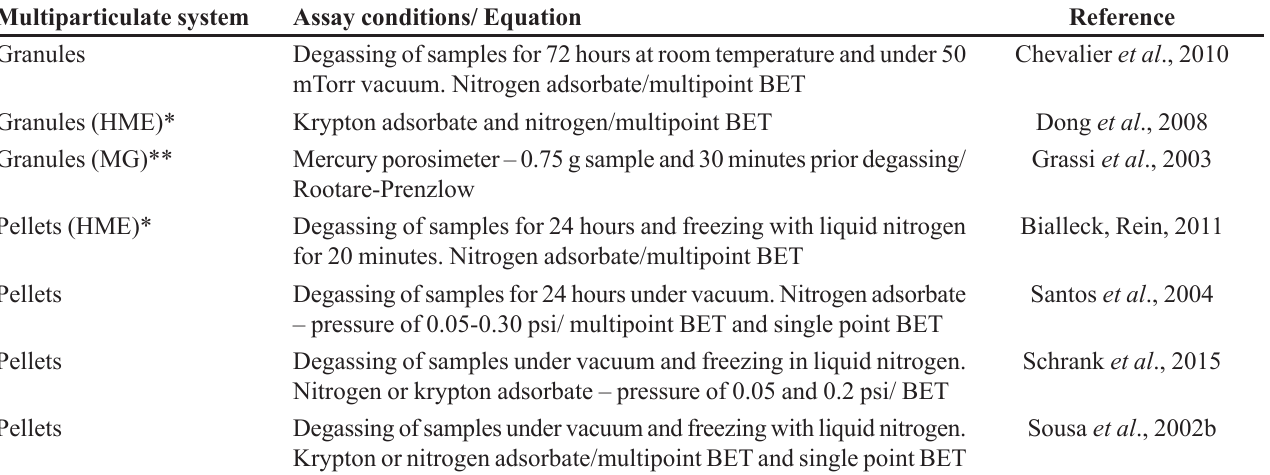
TABLE IV - Examples descriptions of parameters employed in specific surface area analysis Multiparticulate system